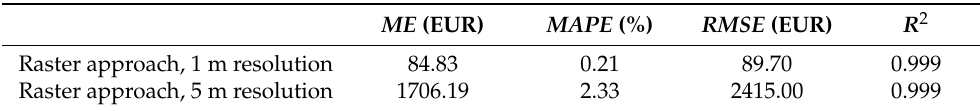
Table 8. Statistical analysis of the LATIS tool with respect to the FLIAT tool for every district road network in Ghent.